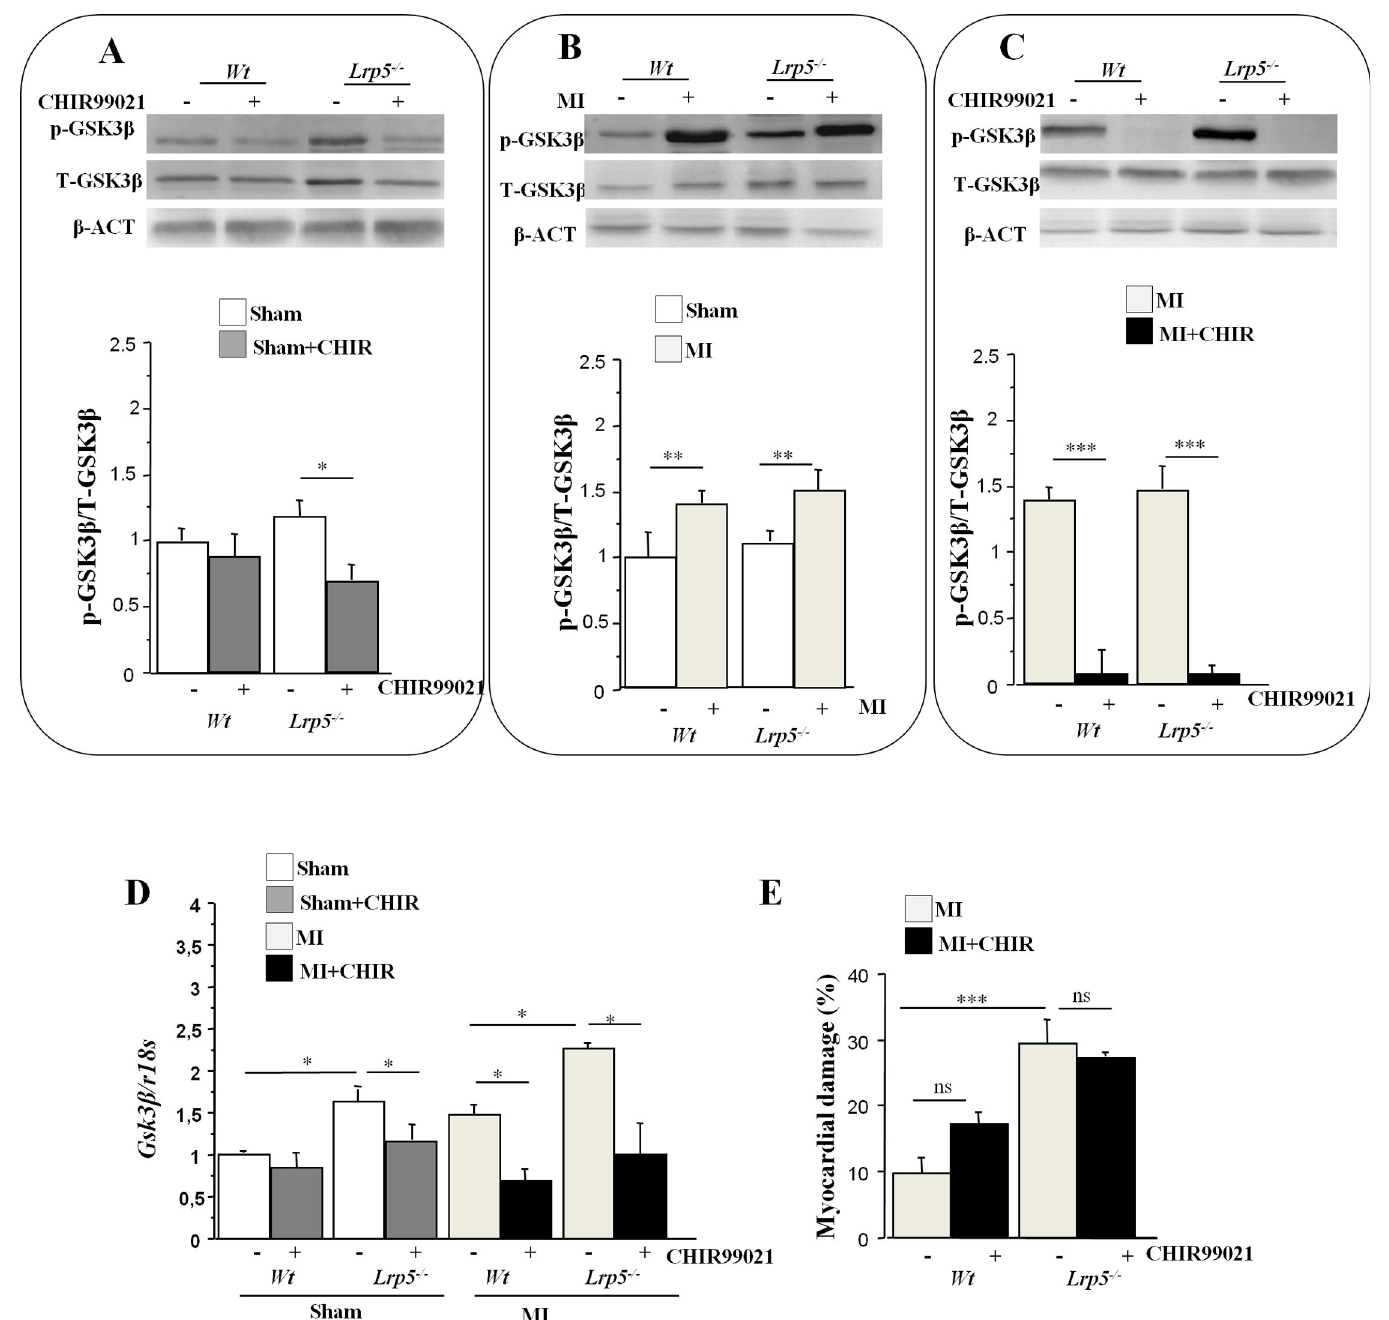
Fig 1. p-GSK3 β levels in hearts of Wt and Lrp5 -/- mice. Representative WB of phosphorylated GSK3 β at Tyr216, total GSK3 β protein and β -ACTIN expression levels in ischemic hearts of Wt and Lrp5 -/- mice (A) with or without 15 mg/kg i.p. CHIR990021 treatments (B) after myocardial injury (MI)-induction and (C) after CHIR99021 treatments and MI induction. Bar graphs showing the quantification of the WB bands intensity p-GSK3 β /T- GSK3 β protein. (D) GSK3 β mRNA expression levels in hearts of Wt and Lrp5 -/- mice with or without CHIR990021 treatments and MI induction. (E) Myocardial damage measurements of Wt and Lrp5 -/- mice after MI in the presence and absence of CHIR99021. 6–10 male mice /condition � p < 0,05; ��� p < 0,005, ns: non